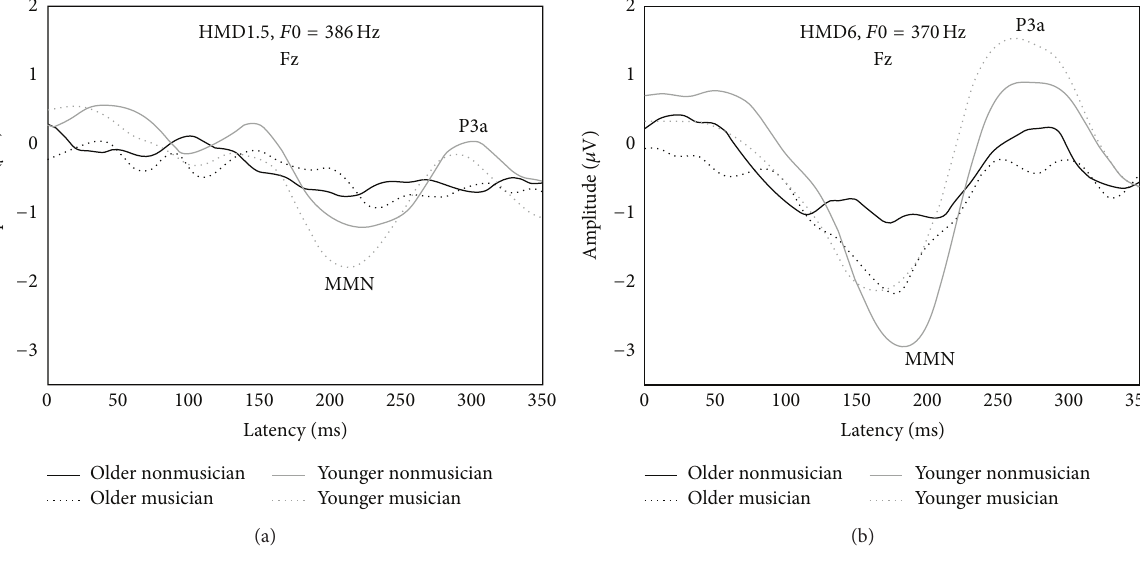
Figure 3: Grand average group difference waveforms (deviant minus standard) at Fz from older adult musicians (OM), older nonmusicians (ONM),youngmusicians(YM),andyoungnonmusicians(YNM)inresponsetoa1.5%frequencydeviance(HMD1.5,(a))anda6%frequency deviance (HMD6,